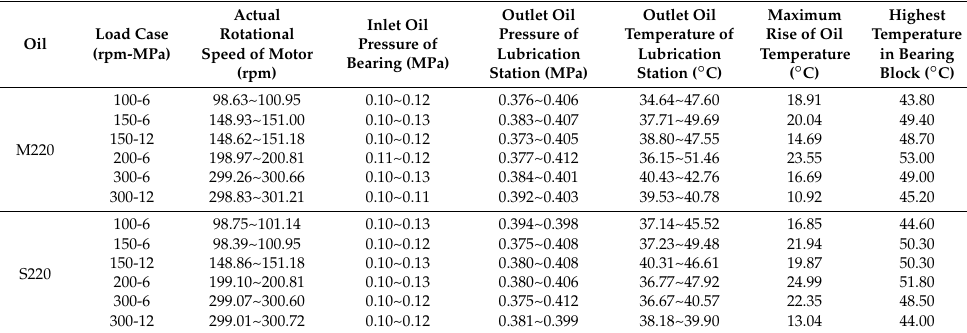
Table 4. Systematic performances under different load cases.